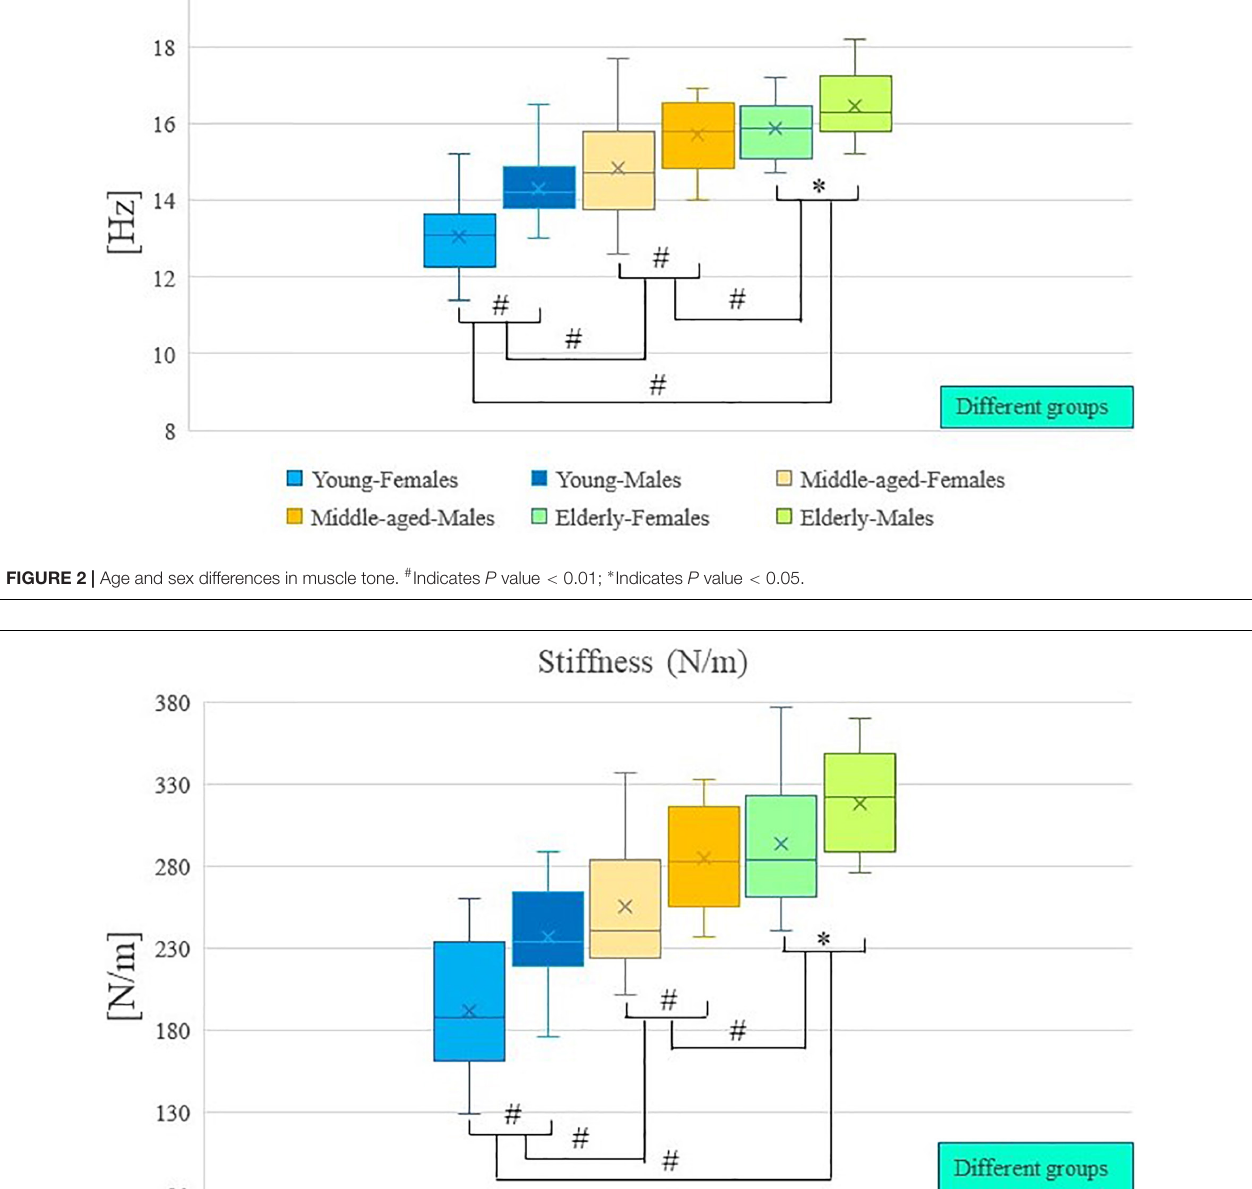
there were sex differences in muscle tone and stiffness within the group. The muscle tone and stiffness of the lumbar erector spinae of male participants were significantly higher than those of females ( P < 0.05; Table 5